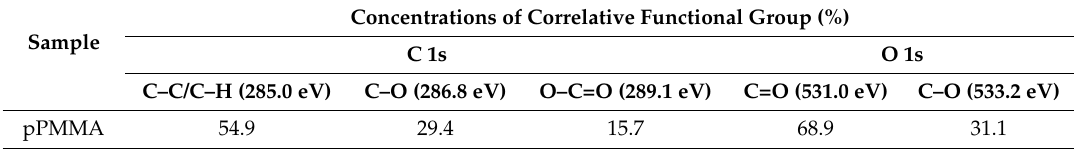
Table 1. The contents of functional groups of C 1s and O 1s core level spectra of plasma-polymerized